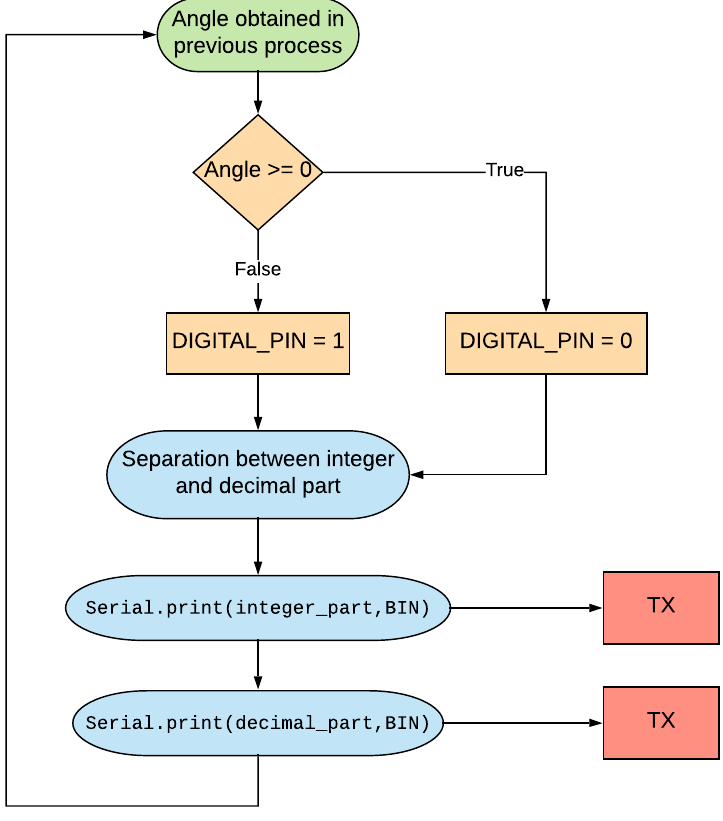
Figure 5. Diagram flow to send angle.